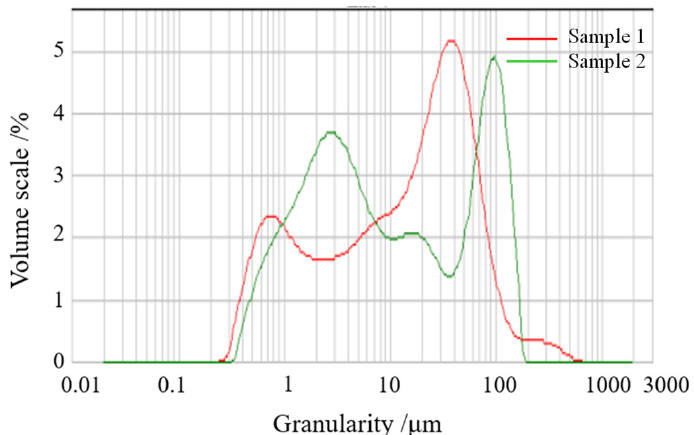
Figure 3. Laser particle size analysis of solid particles in the drilling fluid.